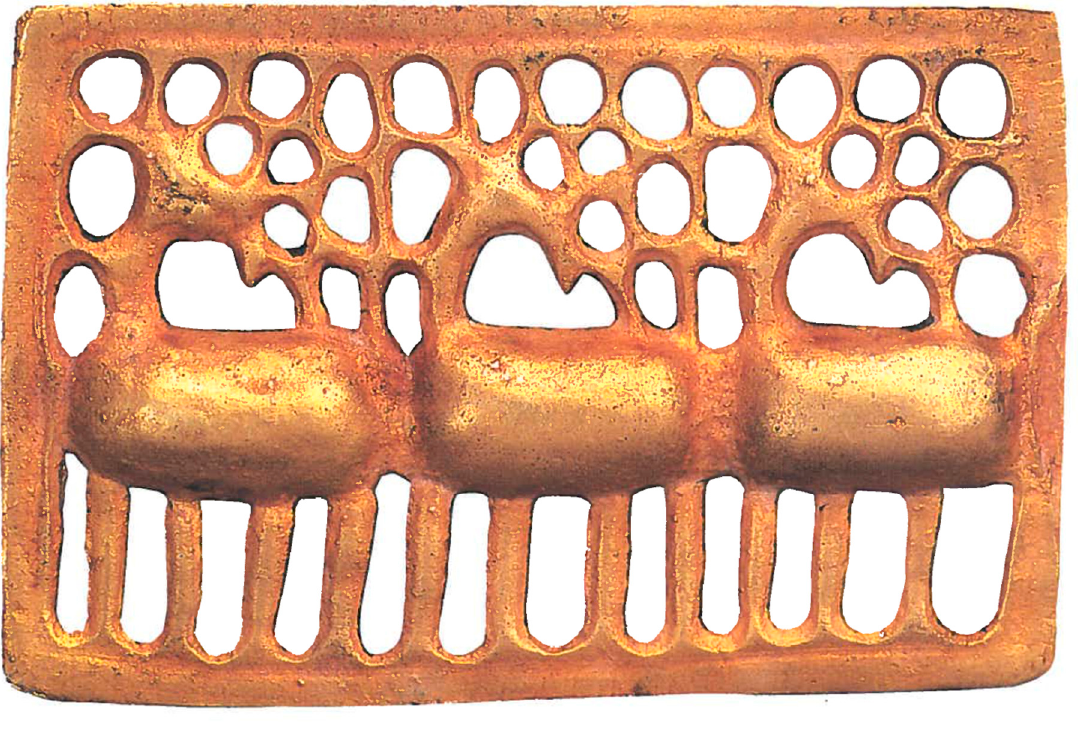
Figure 1. Three‑deer plaque, gold, 6.8 × 4.5 cm, excavatedfrom Jingtancun, Qahar Right Rear Banner, Figure 1. Three-deer plaque, gold, 6.8 × 4.5 cm, excavated from Jingtancun, Qahar Right Rear Inner Mongolia; after (Zhang 1995, p. Banner, Inner Mongolia; after (Zhang 1995, p. 79).